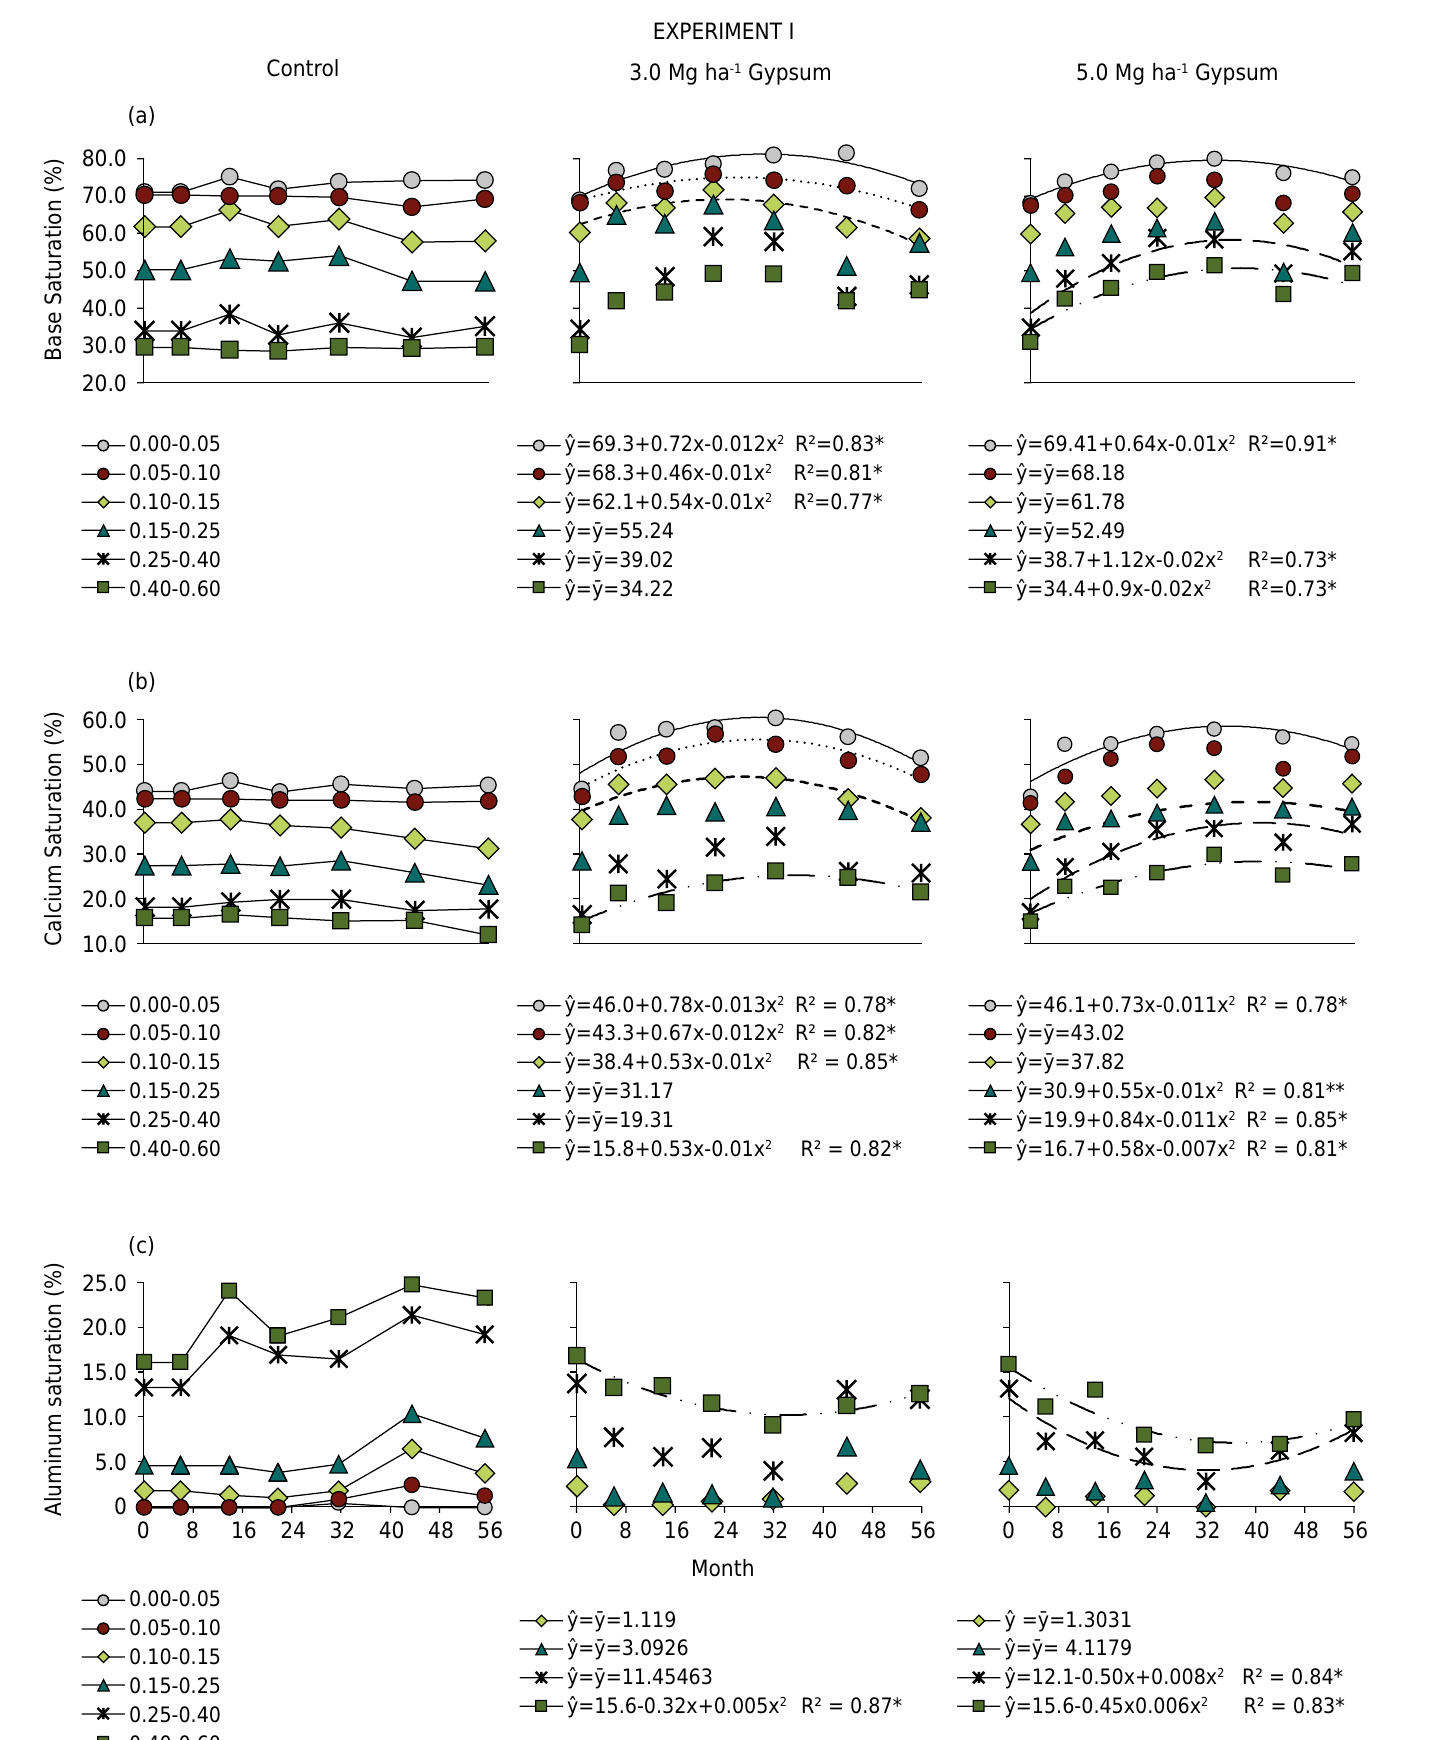
Figure 3. Time effect of the rates of 0.0, 3.0, and 5.0 Mg ha -1 of gypsum on Ca saturation (a), base saturation (b), and Al saturation (c) for Experiment I. * and ** : significant at 5 and 1 % probability of error,